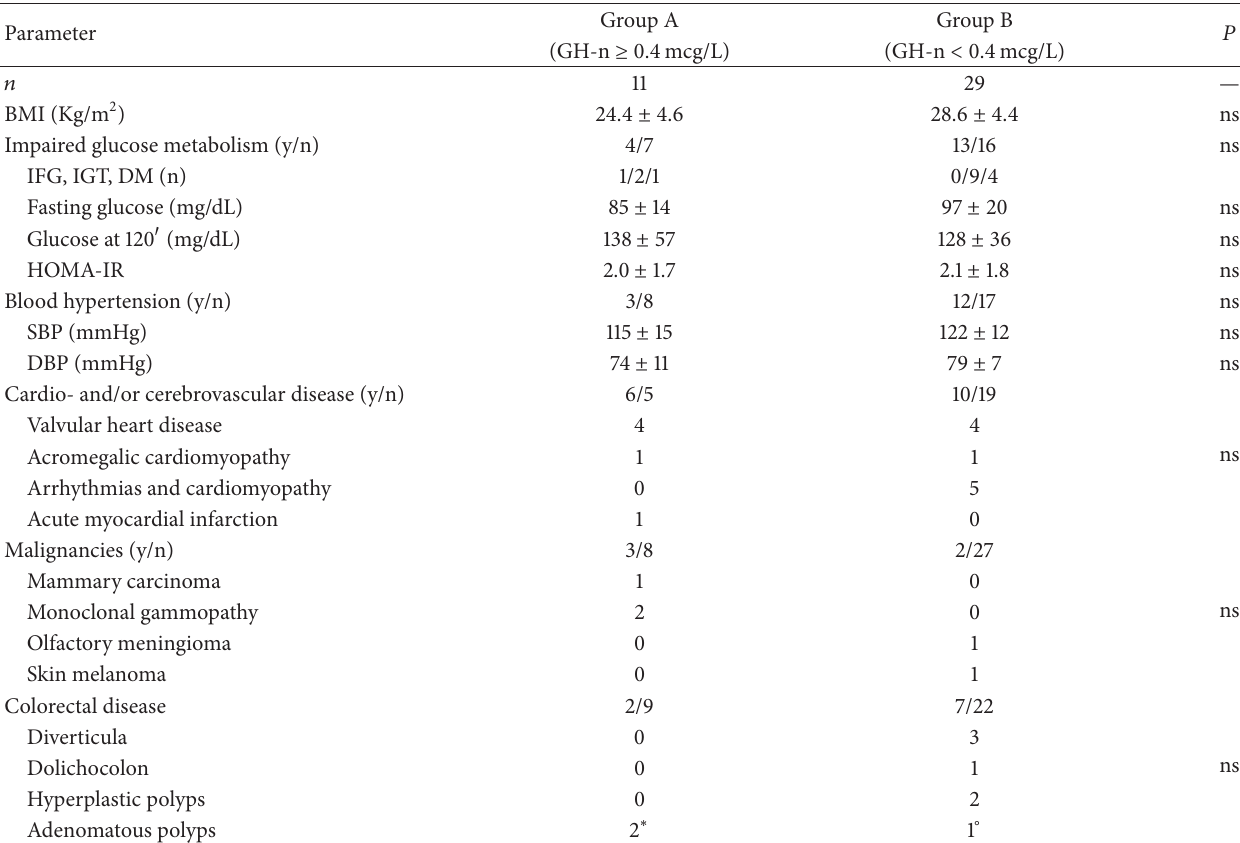
Table 3: Comparison of metabolic and comorbid data between patients with postglucose GH nadir over (group A) and below 0.4 𝜇 g/L (group B) at last